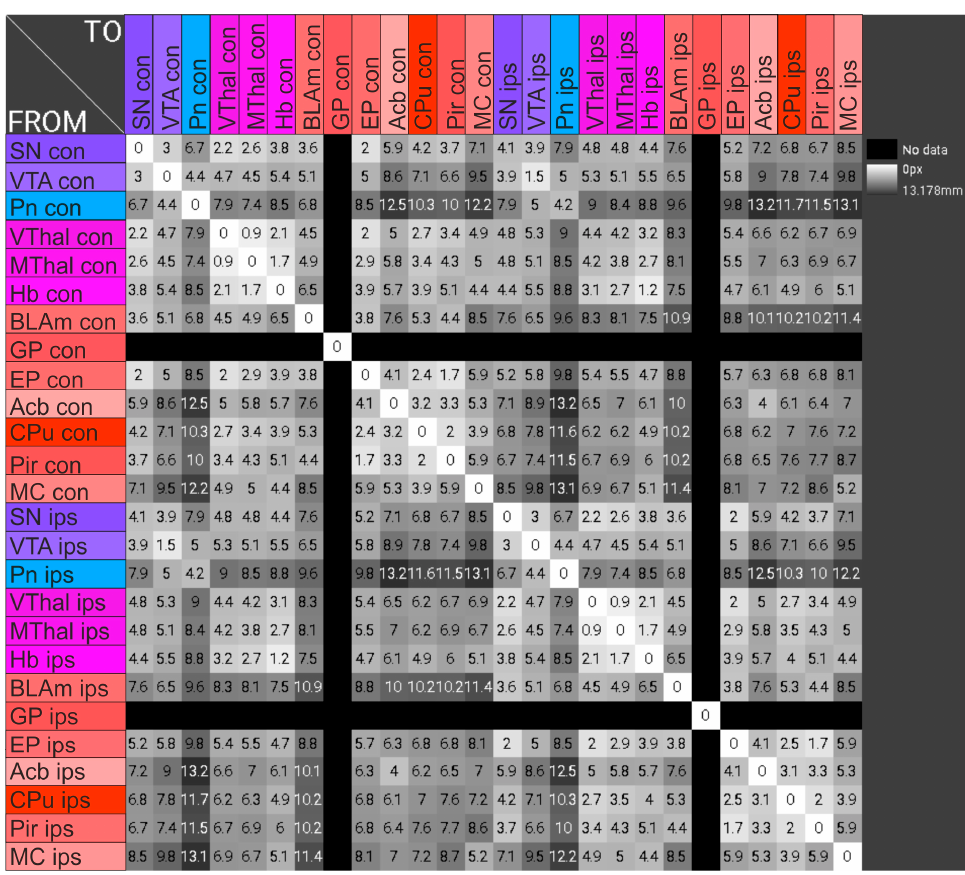
Figure 7. The distances of the gravitational centers of selected brain areas to each other, in mm, were determined with the program neuroVIISAS. This again draws on datasets from a large number of publications on connectome studies. With the help of neuroVIISAS, the distances of the gravitational centers of the examined brain areas to the injected CPu were determined.